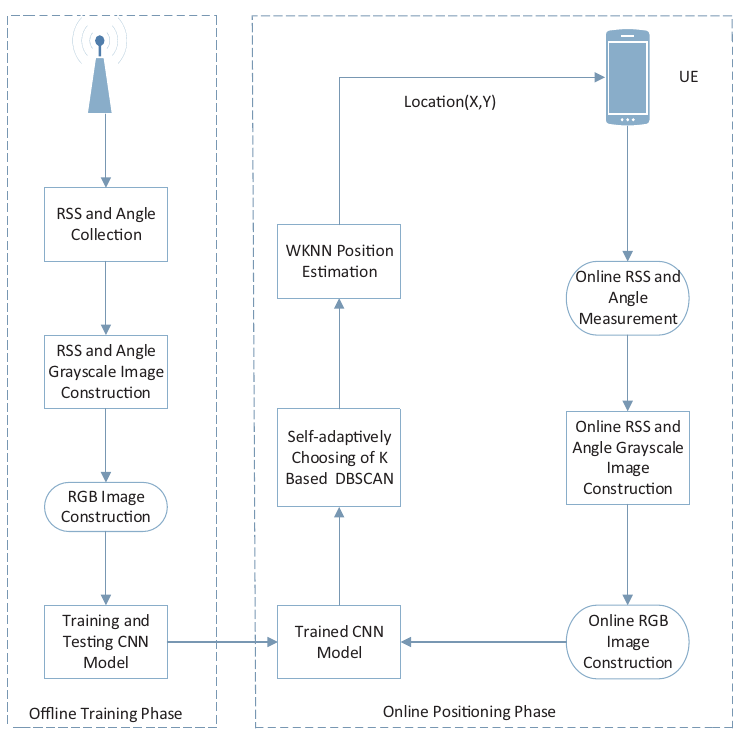
Figure 3. Complete CNN positioning system implementation (offline training phase and online positioning phase).